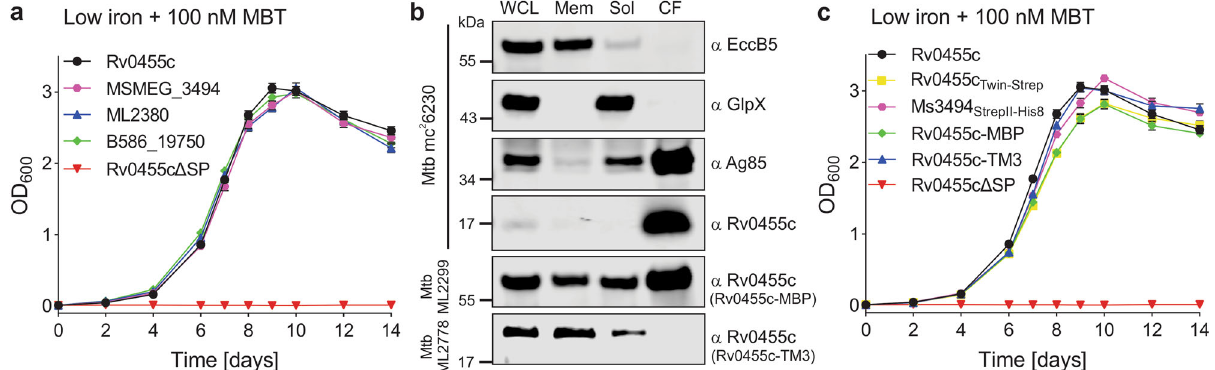
Fig. 2 Rv0455c is a conserved 14-kDa exported protein. a Growth curves of the M. tuberculosis Δ rv0455c mutant complemented with genes encoding the Rv0455c homologs MSMEG_3494 of M. smegmatis ( M. tuberculosis ML2770), ML2380 of M. leprae ( M. tuberculosis ML2294) and B586_19750 of M. haemophilum ( M. tuberculosis ML2295) in 7H9 low iron (<0.1 μ M Fe 3 + ) medium supplemented with 100 nM Fe-mycobactin (Fe-MBT). The Δ rv0455c strains complemented with genes encoding Rv0455c (by M. tuberculosis ML2205) and Rv0455c Δ SP (Rv0455c 31-148 ; by M. tuberculosis ML2206) were used as positive and negative controls, respectively. Error bars represent standard deviations from the mean results of biological triplicates ( n = 3). b Subcellular localization of Rv0455c in M. tuberculosis mc 2 6230. Immunoblot analysis of the whole-cell lysate (WCL), the membrane (Mem) and water- soluble fractions (Sol), and of the culture fi ltrate (CF). The culture fi ltrate was concentrated 200-fold. Five microliter of each fraction taken from the WCL, Mem2, Sol2, and CF fractions were loaded into 8% SDS-PAGE gels for Western blots. The Rv0455c proteins were detected with an Rv0455c-speci fi c antiserum. EccB5, GlpX, and Ag85 served as indicator proteins for the membrane-associated proteins, soluble proteins, and secreted proteins, respectively. Data were obtained from at least two independent experiments and representative images are shown. c Growth curves of the M. tuberculosis Δ rv0455c mutant (strain ML2203, Table S1) complemented with genes encoding Twin-Strep tagged Rv0455c (ML2298), StrepII-His 8 tagged MSMEG_3494 (ML2293), Rv0455c-MBP (ML2299) and Rv0455c-TM3 (ML2778), respectively, in 7H9 low-iron medium (<0.1 μ M Fe 3 + ) supplemented with 100 nM Fe- mycobactin (Fe-MBT). Error bars represent standard deviations from the mean results of biological triplicates ( n = 3). Source data are provided in the Source Data fi